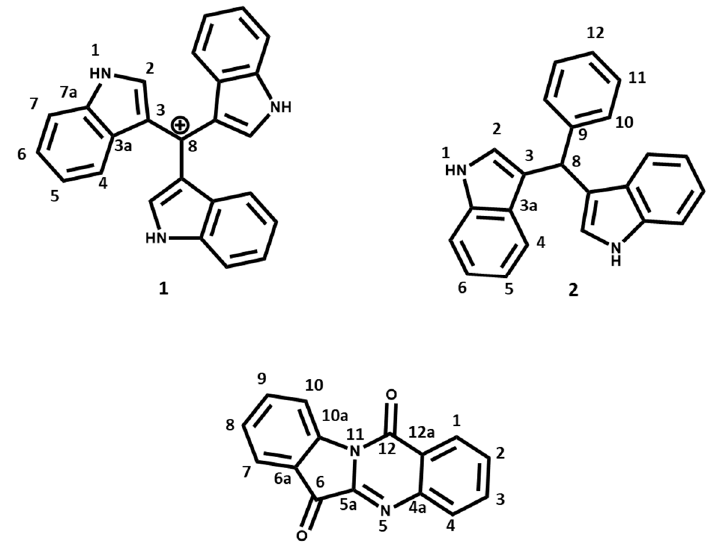
Figure 1. Antibacterial compounds isolated from Pseudomonas aeruginosa UWI-1. ( 1 ) tris(1 H -indol-3-yl) methylium; ( 2 ) bis(indol-3-yl)phenylmethane; and ( 3 ) indolo (2, 1b) quinazoline-6, 12 dione (Tryptanthrin). Table 1. H and 13 C NMR data for compounds 1 and 2